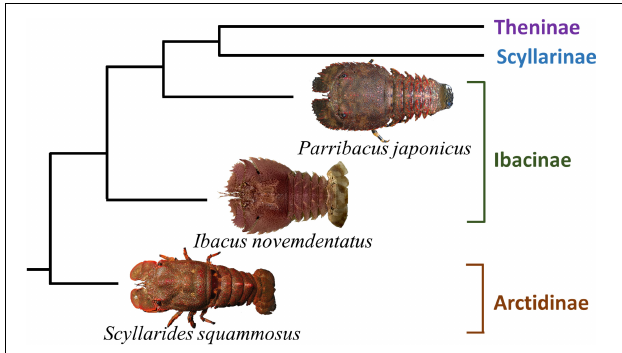
FIGURE 1 | A cladogram showing the evolutionary relationships among the three focus species of this study (based on Yang et al., 2012).